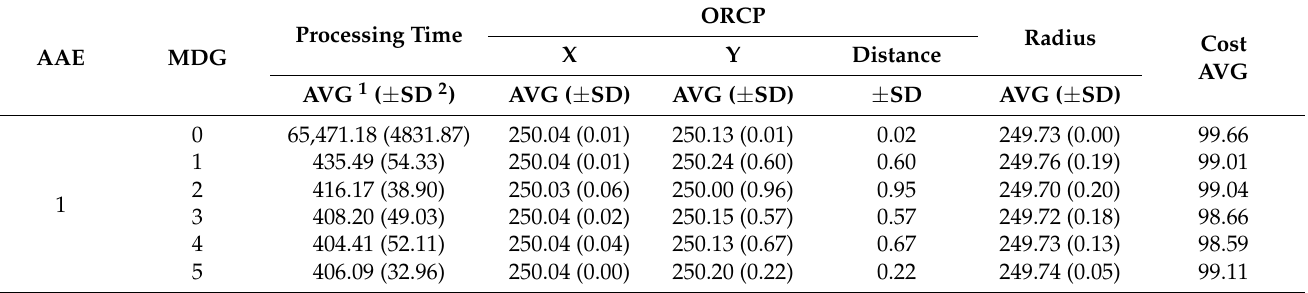
Table 2. Performance of HPOM estimation according to AAE and